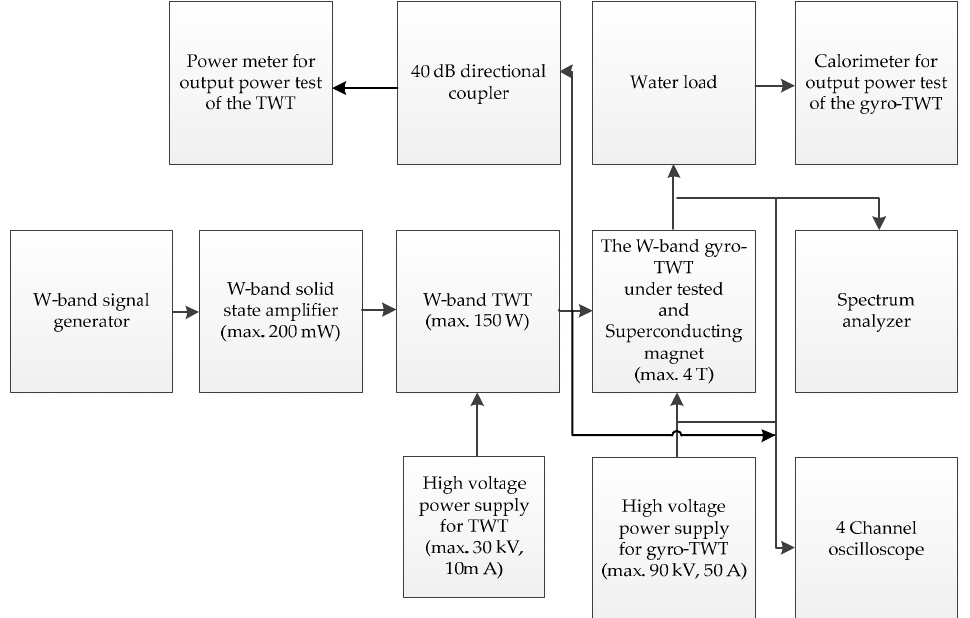
Figure 14. Hot test system diagram of the W-band TE 02 mode gyro-TWT.